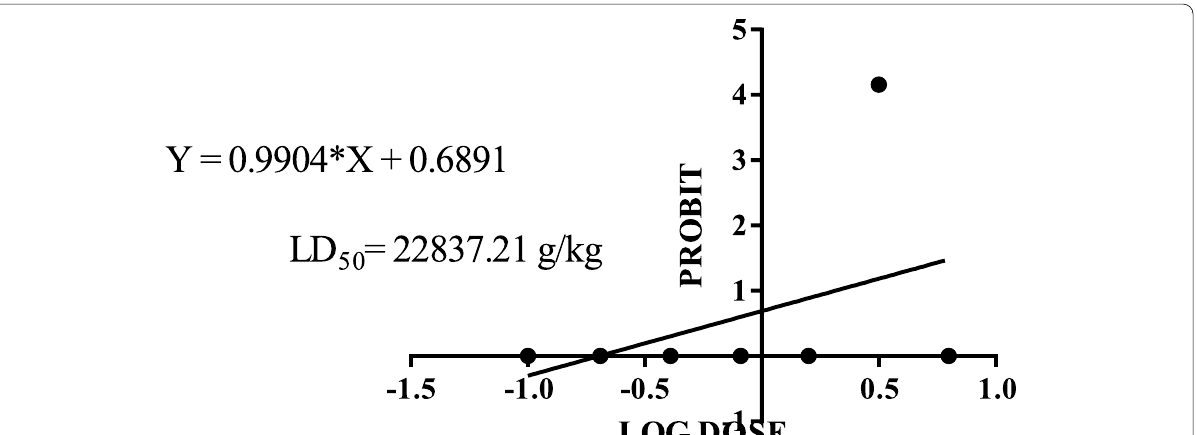
Fig. 1 Probit analysis of dose-dependent mortality curve for Mystomate4 ® and the calculation of the LD 50 n using probit analysis in Graph pad